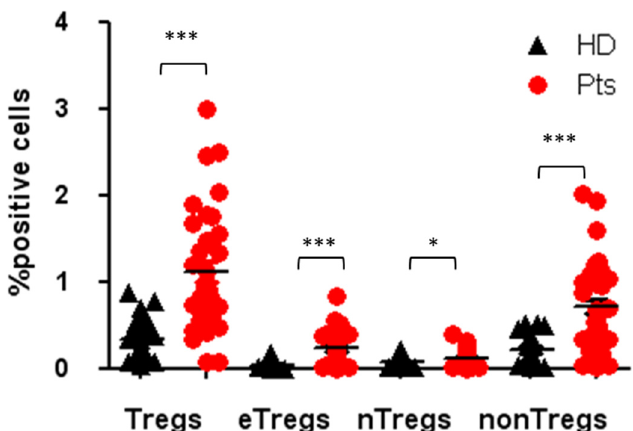
Figure 3. Tregs and Tregs subpopulation in patients and HDs at the baseline. Percentage of circulating Tregs, eTregs, nTregs, non-Tregs in patients and healthy donors, expressed as percentage of cells positives for the relative markers reported in Figure 2. * p < 0.05; *** p < 0.0005. Pts, patients; HDs, Healthy donors.